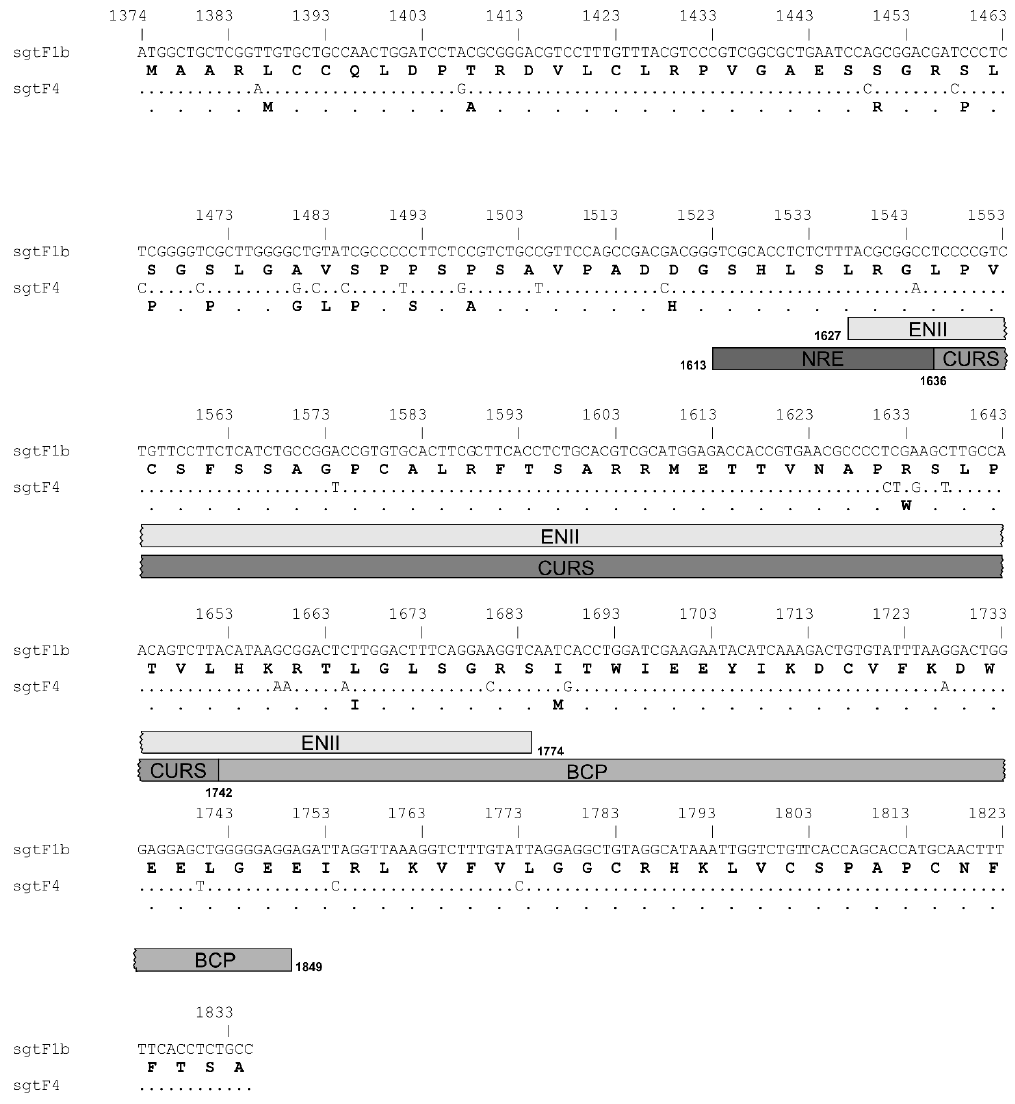
Figure 4. Nucleotide and amino acid alignment of sgtF1b and sgtF4 X gene/protein. The location of